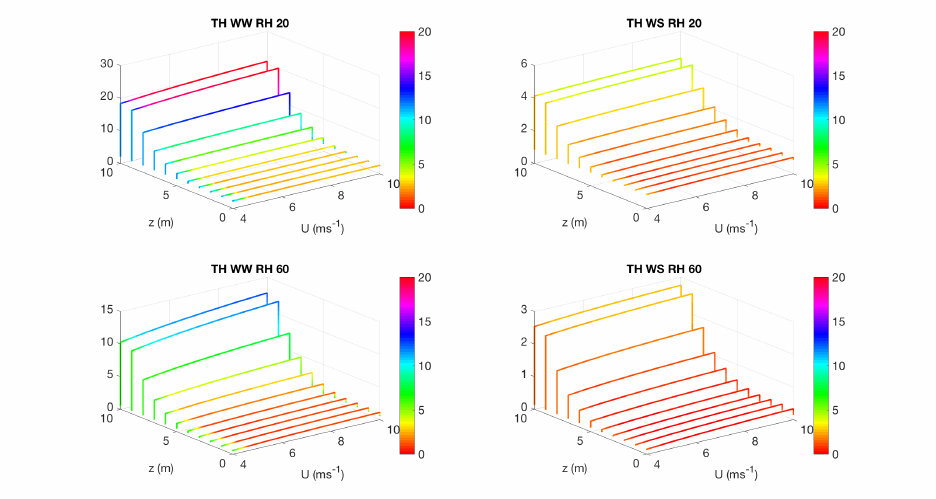
Figure 4. Variations of leaf level transpiration fe (molm − 2 leafs − 1 ) with wind speed U and height z for the top heavy (TH) scenario for the following four cases in low light conditions. WW RH20 means well watered, high evaporative demand; WS RH20 means water stressed, high evaporative demand; WW RH60 means well watered, low evaporative demand; WS RH60 means water stressed, low evaporative demand. Color bars show fe multiplied by 1000, x axes show wind speed U in ms − 1 and y axes show canopy height z in